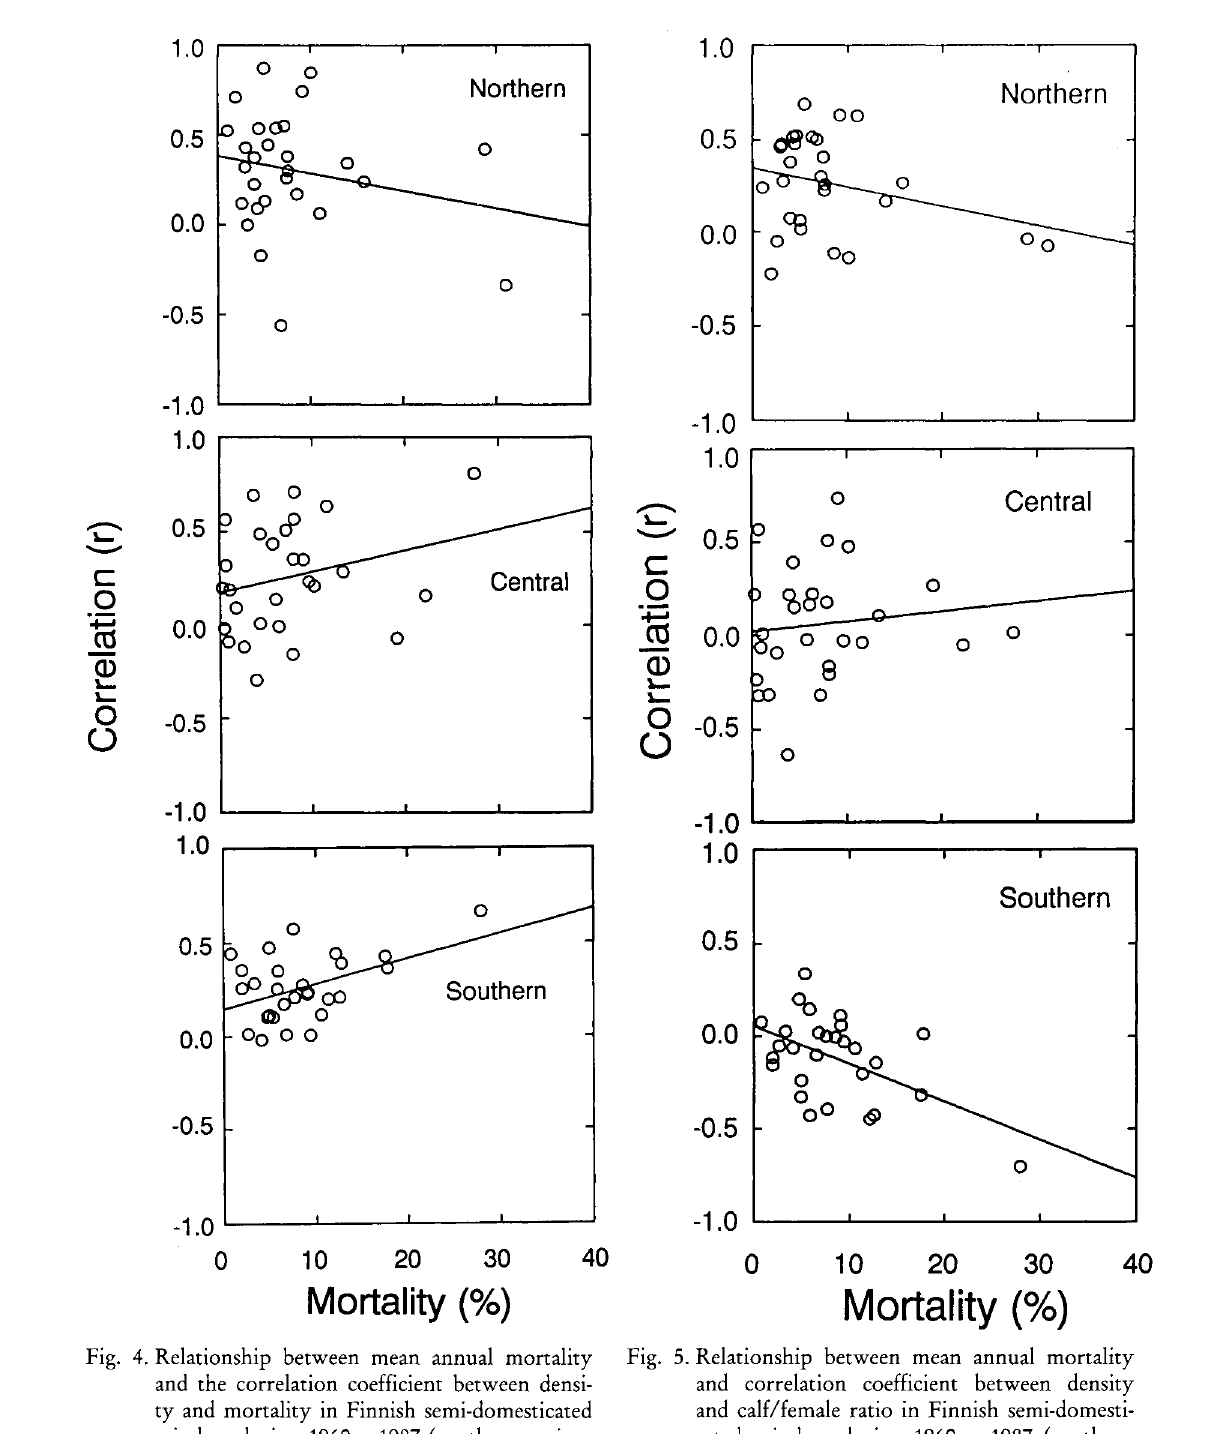
Fig 5. Relationship between mean annual mortality and correlation coefficient between density and calf/female ratio in Finnish semi-domesti cated reindeer during 1960 - 1987 (northern region: y = 0.350 - 0.010X, r = -0.280, n = 28, P = 0.144; central region: y = 0.023 + 0.005X, r = 0.117, n = 28, P = 0.311; south ern region: y = 0.057 - 0.020X, r = - 0.515, n = 28, P =